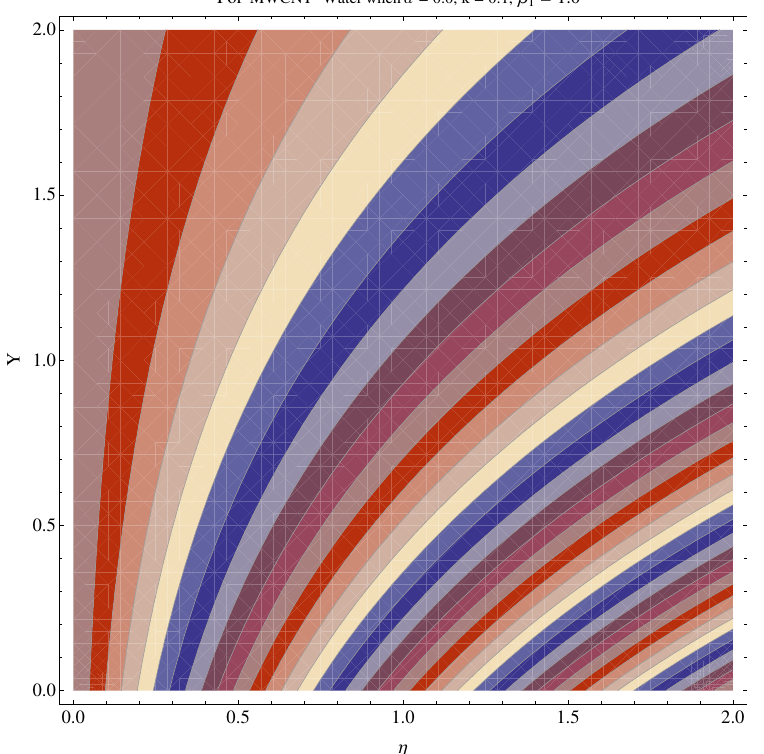
Figure 16. Contour graph at β 1 = 1.0 for